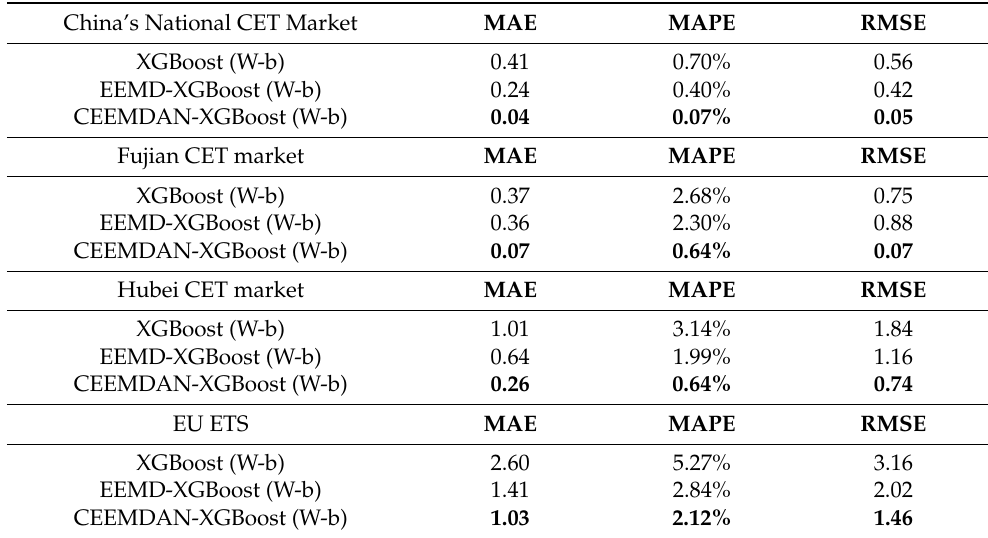
Table 6. The error of the forecasting models based on different decomposition methods.